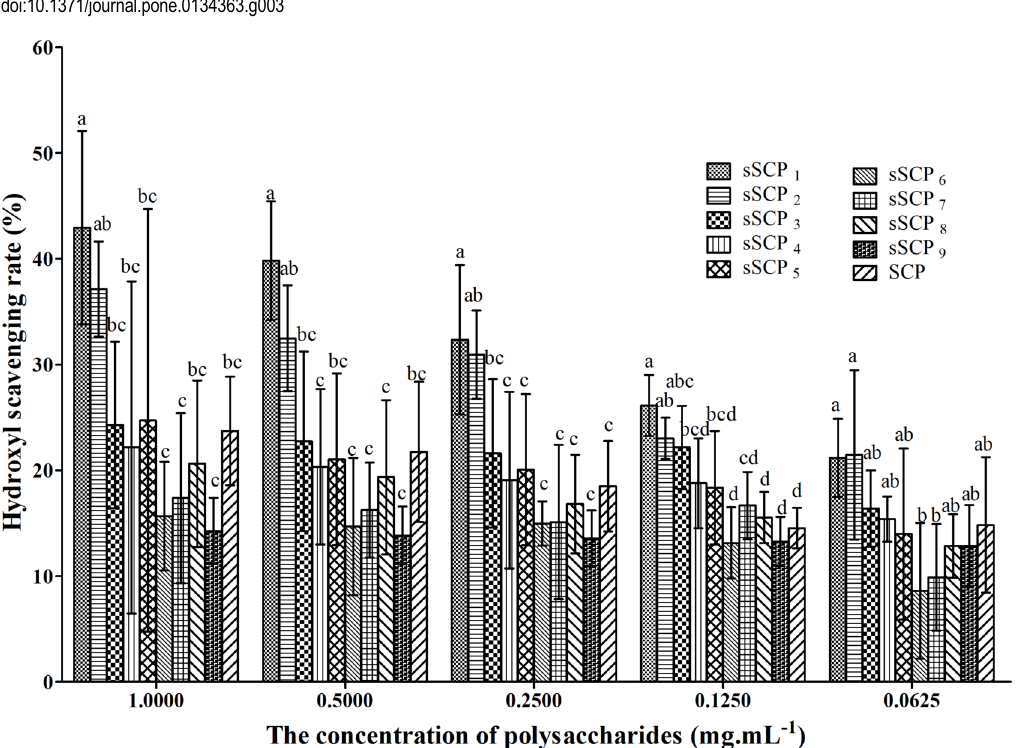
Fig 4. The hydroxyl radical-scavenging rates in each group at five concentrations (TBARS). Bars in same concentration without same superscripts (a – d) differ significantly (P < 0.05). doi:10.1371/journal.pone.0134363.g004 PLOS ONE | DOI:10.1371/journal.pone.0134363 July 31,